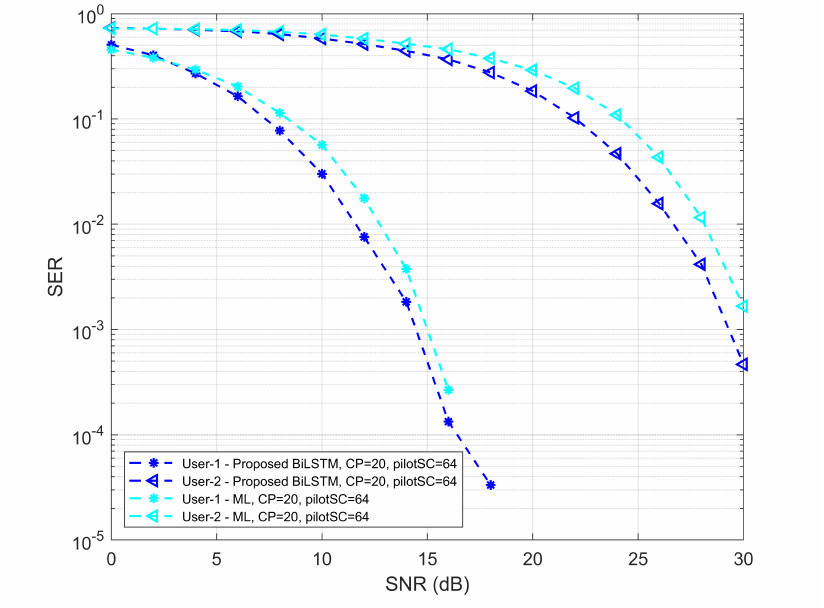
Figure 10. SER versus SNR performance of proposed Bi-LSTM model and ML method.